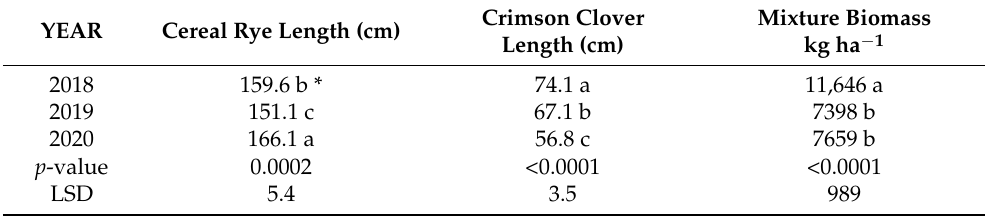
Table 4. Plant length in the mixture of cereal rye/crimson clover and combined biomass